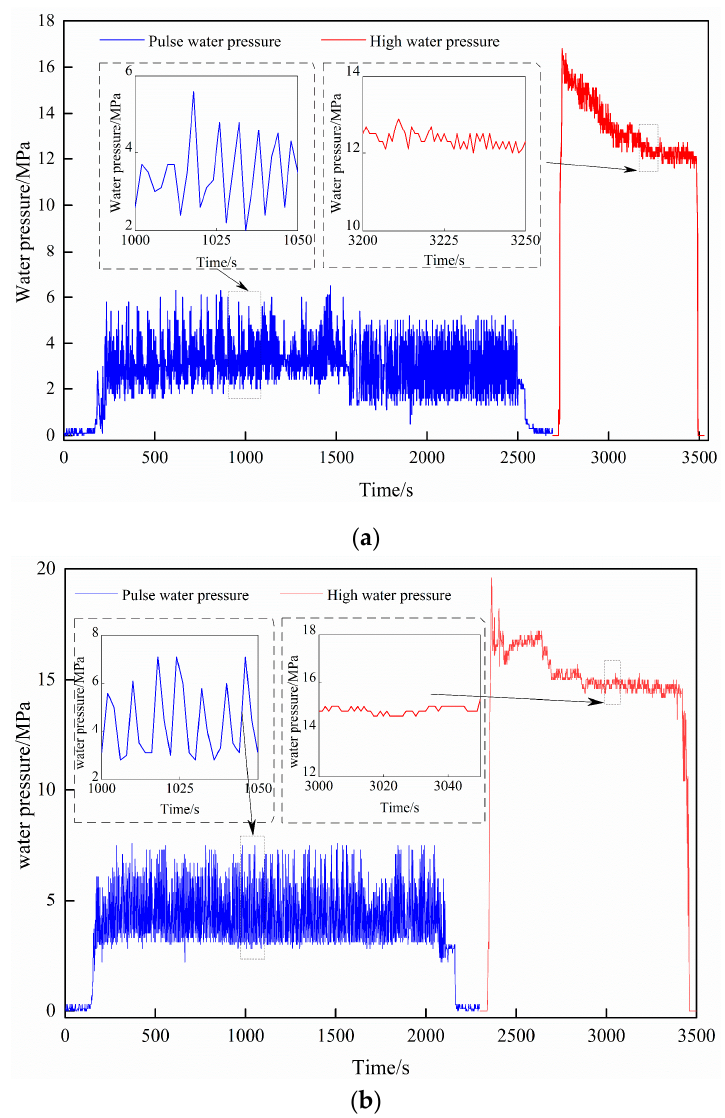
Figure 9. Water pressure during hydraulic fracturing: ( a ) S 18 borehole and ( b ) S 19 borehole.